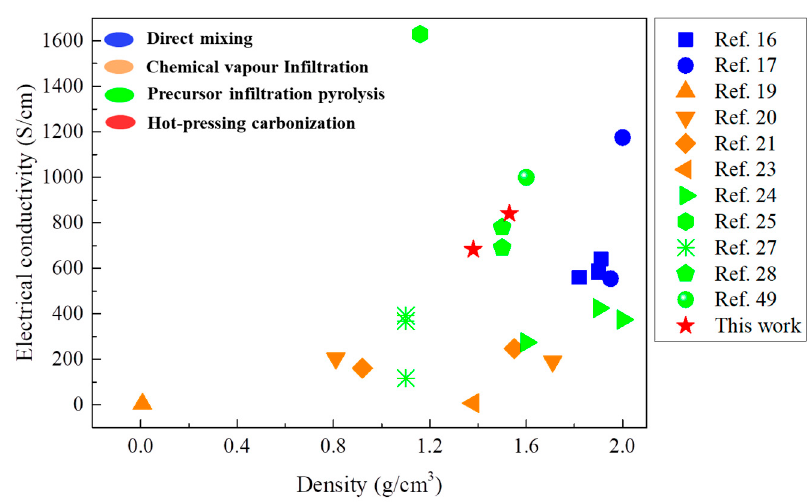
Figure 10. Plots of electrical conductivity of the studied CNTF/MPC nanocomposites, in comparison with the reported values of different CNT/C bulk composites.